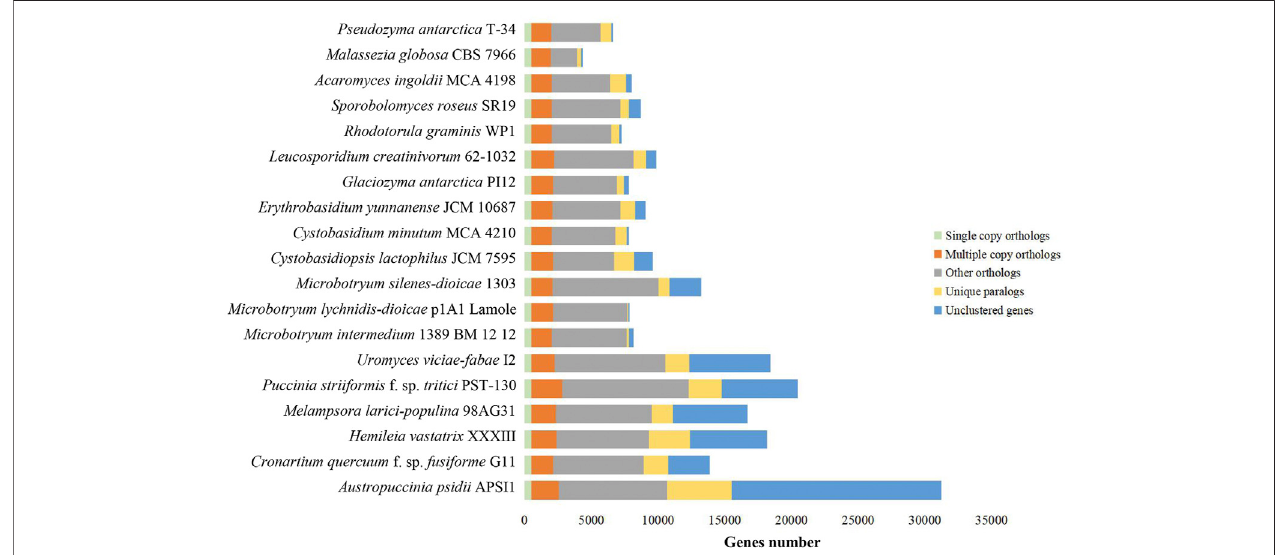
FIGURE 1 | Orthologous groups for 19 selected fungi. Bars are subdivided to represent fi ve different types of orthologs ’ relationships. “ Single_copy_orthologs ” indicates one to one gene among all selected fungi. “ Multiple_copy_orthologs ” indicates other conserved genes present in multiple copies among all selected fungi. “ Other_orthologs ” indicates those genes present in at least two fungi, but not all fungi. “ Unique_paralogs ” indicates species-speci fi c duplicated genes. “ Unclustered_genes ” indicates no homologous relationship between one and any other taxa.